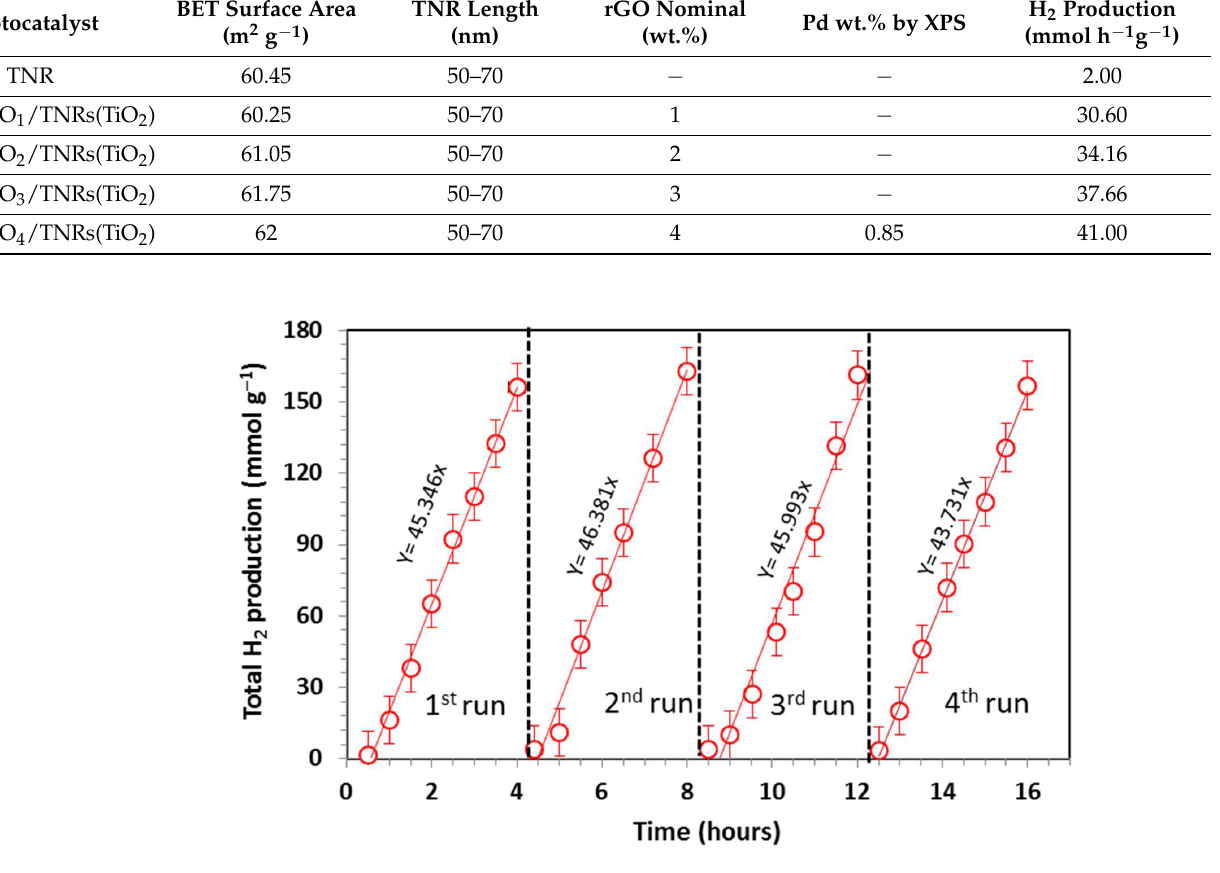
Figure 8. Consecutive runs for the hydrogen generation tests with Pd 1 /rGO 4 − TNRs catalysts using 5% glycerol−water mixtures.